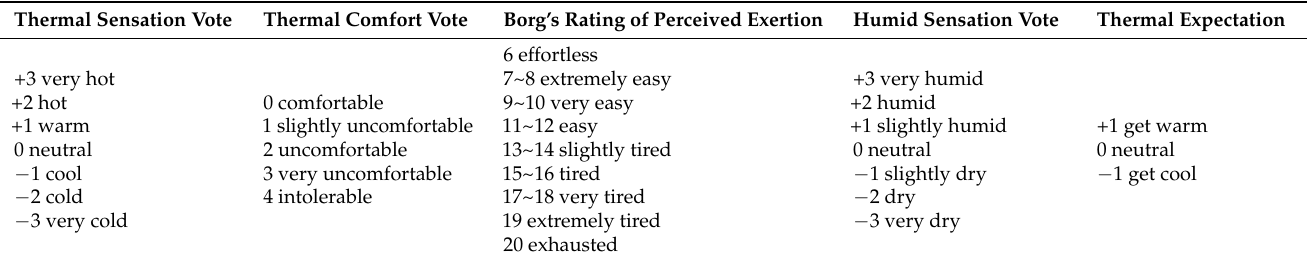
Table 3. Perceptual response voting